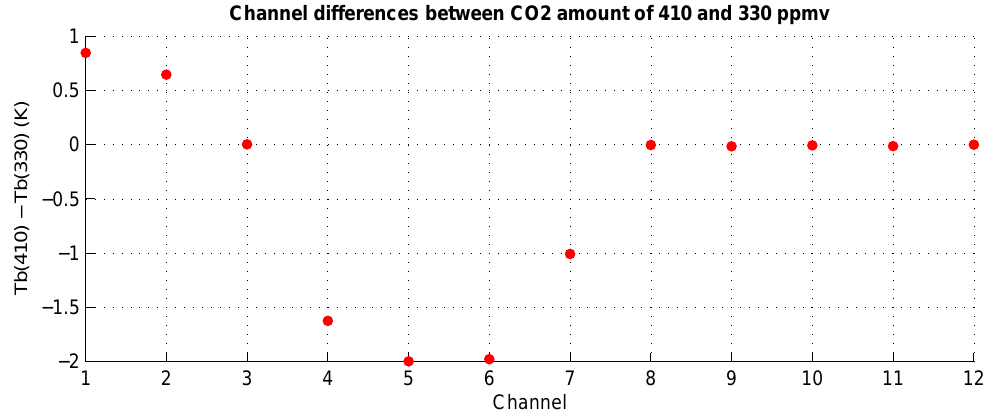
Figure 1. RTTOV model simulation of brightness temperature differences for HIRS channels 1–12 between CO 2 amount of 410 and 330 ppmv.